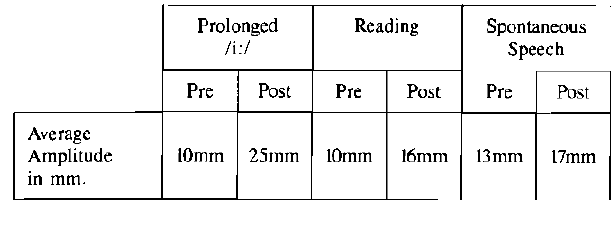
Table 4 Changes in average amplitude of waveforms pre- and post-therapeutically. Prolonged Reading Spontaneous /i:/ Speech